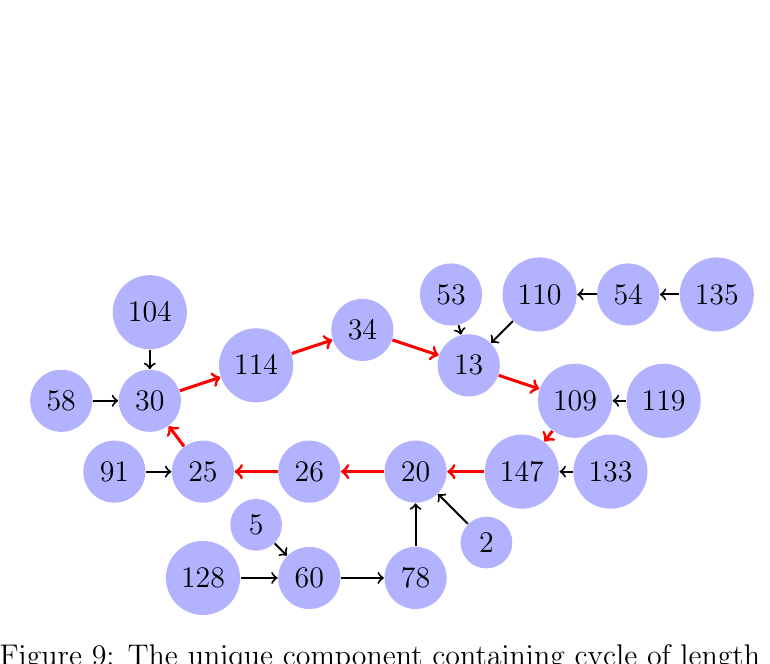
Figure 9: The unique component containing cycle of length